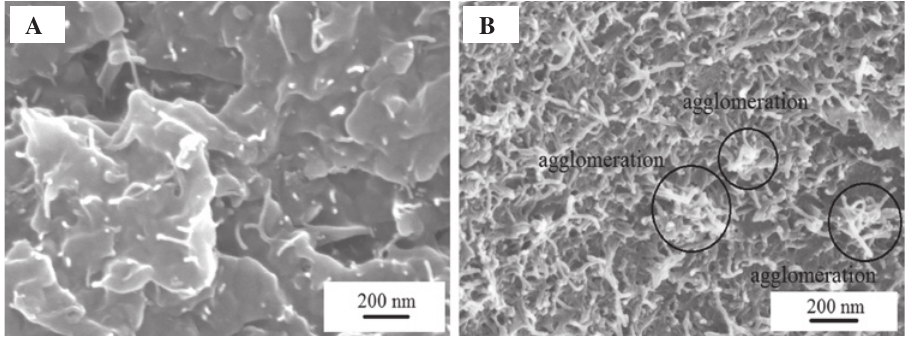
Figure 6: SEM micrographs of the fractured surfaces of (A) 5 wt.% MWCNT/PC composites and (B) 10 wt.% MWCNT/PC composites obtained at the injection temperature of 330 ° C and injection speed of 10